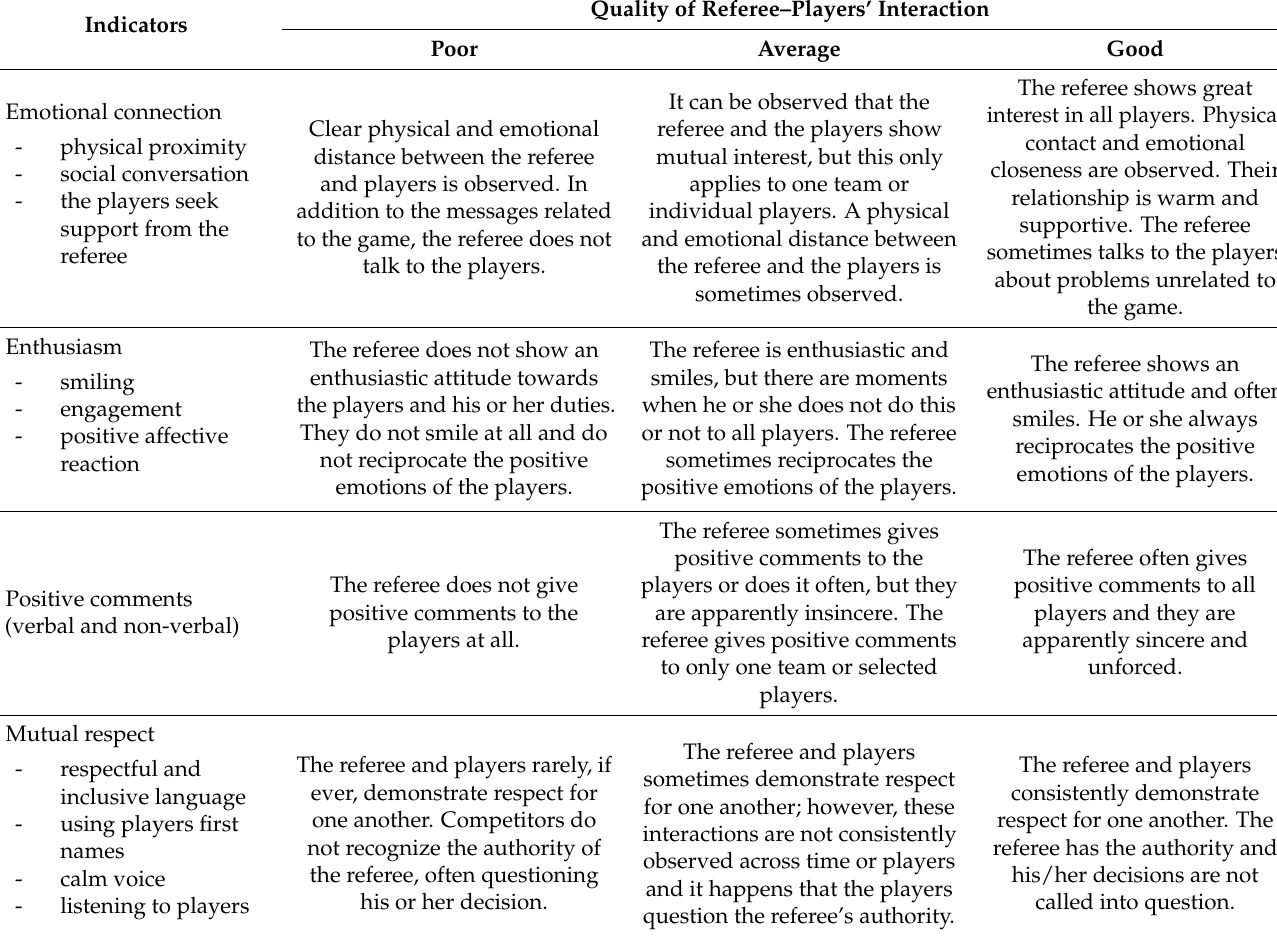
Table 1. Descriptions of indicators of building a positive climate